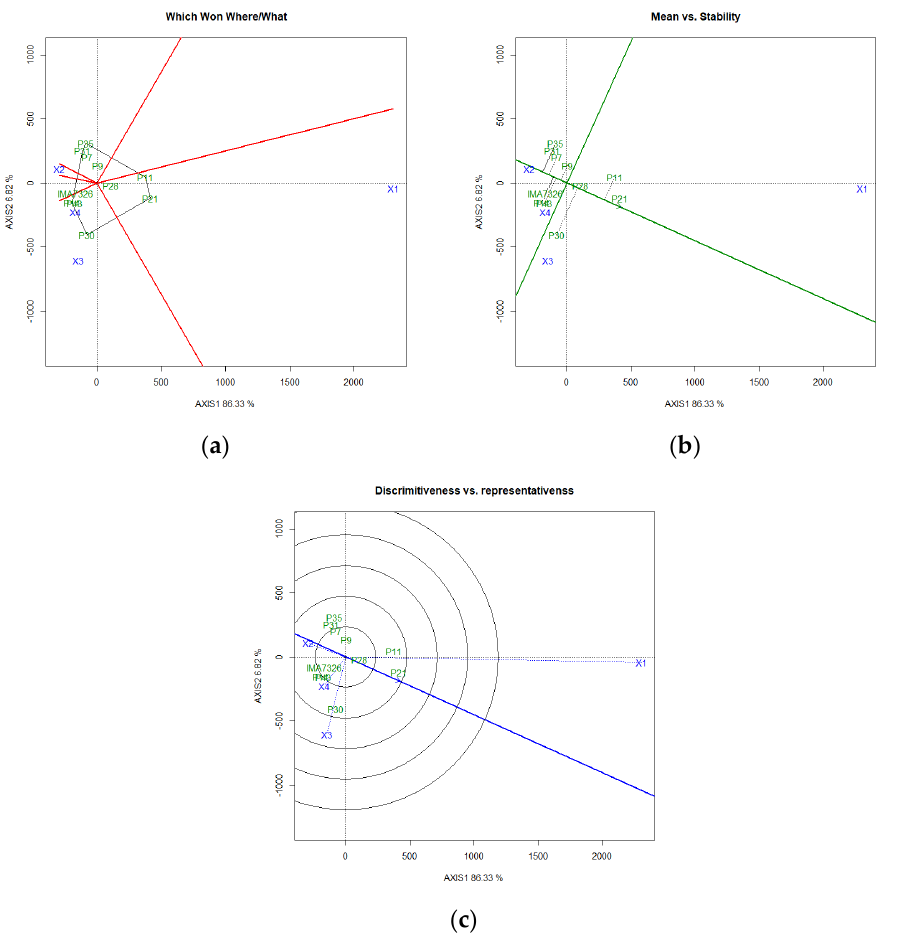
Figure 1. Polygon ( a ), stability ( b ), and ideal environment ( c ) tested for grain yield obtained by the GGE biplot method in safflower genotypes grown in four environments of the Brazilian Cerrado. Environments: X1: Bauru-SP; X2: Botucatu-SP(1); X3: Botucatu-SP(2); X4: Campo Novo do Parecis-MT.